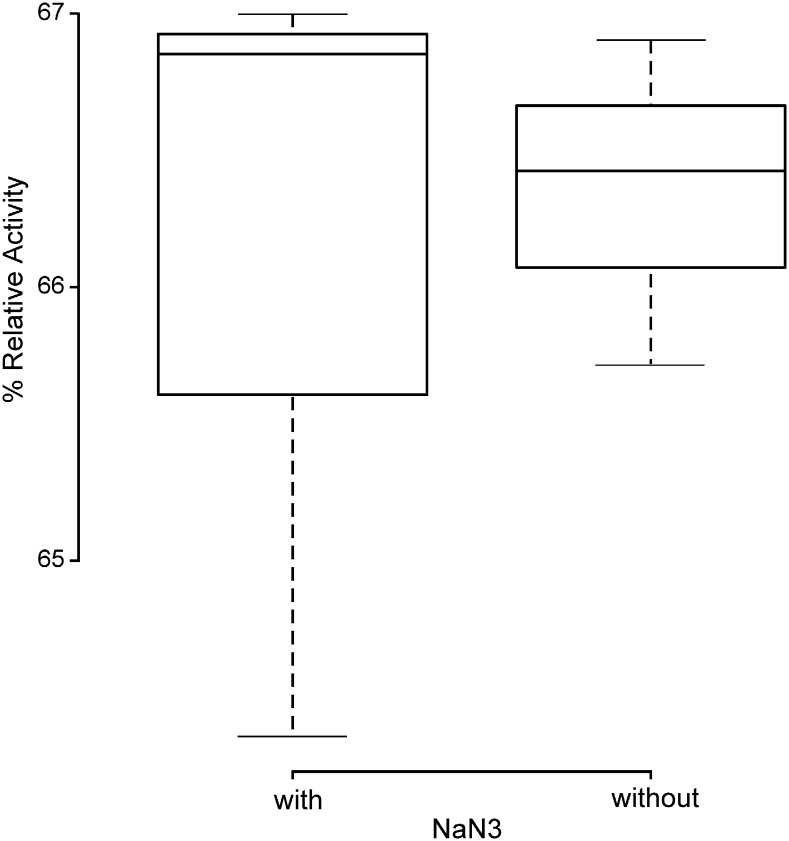
Effect of 0.05% w/v NaN3 on protease activity. Centre lines show the medians; box limits indicate the 25th and 75th percentiles; whiskers extend 1.5 times the interquartile range from the 25th and 75th percentiles. Statistical significance was determined by the student's t-test. (P > 0.05).